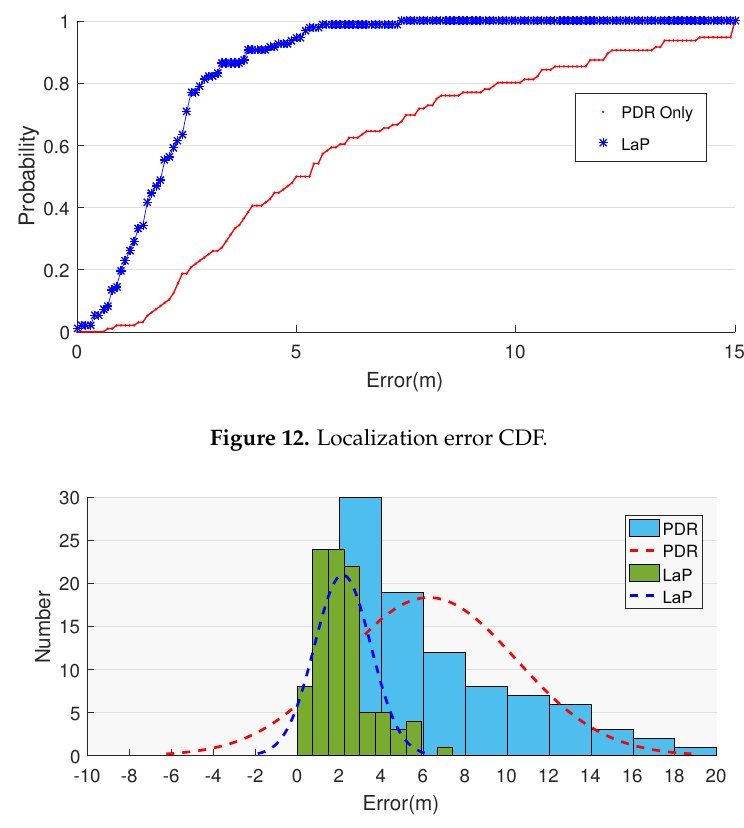
Figure 13. Location error